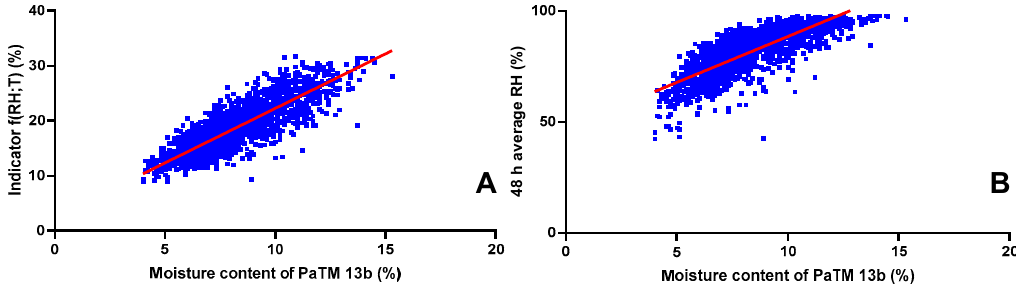
Figure 8. Correlation between MC of thermally modified wood (window sill, PaTM 13b) and selected indicators: ( A ) Value calculated according to Equation (1), considering average RH 48 h and average temperature 48 h before MC measurements (f(RH; T)) (R = 0.84; p < 0.0001); ( B ) Two-day average RH (48 h average RH) ( R = 0.80; p < 0.0001). The trend line is red.